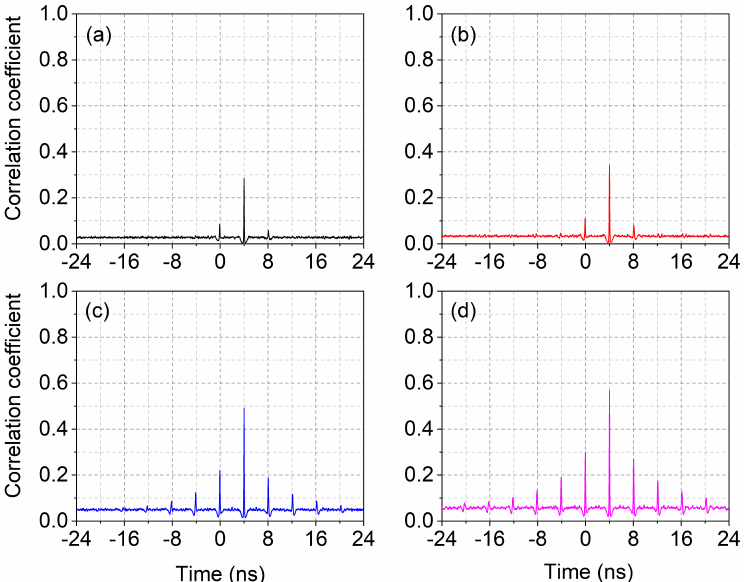
Figure 6. Cross-correlations between intracavity stimulated photons and fraction of reinjected (stimulated) photons from previous pulses. Parameters: P = 1.6 P th , η = 0.005 ( a ); P = 1.5 P th , η = 0.01 ( b ); P = 1.3 P th , η = 0.05 ( c ); P = 1.15 P th , η = 0.1 ( d